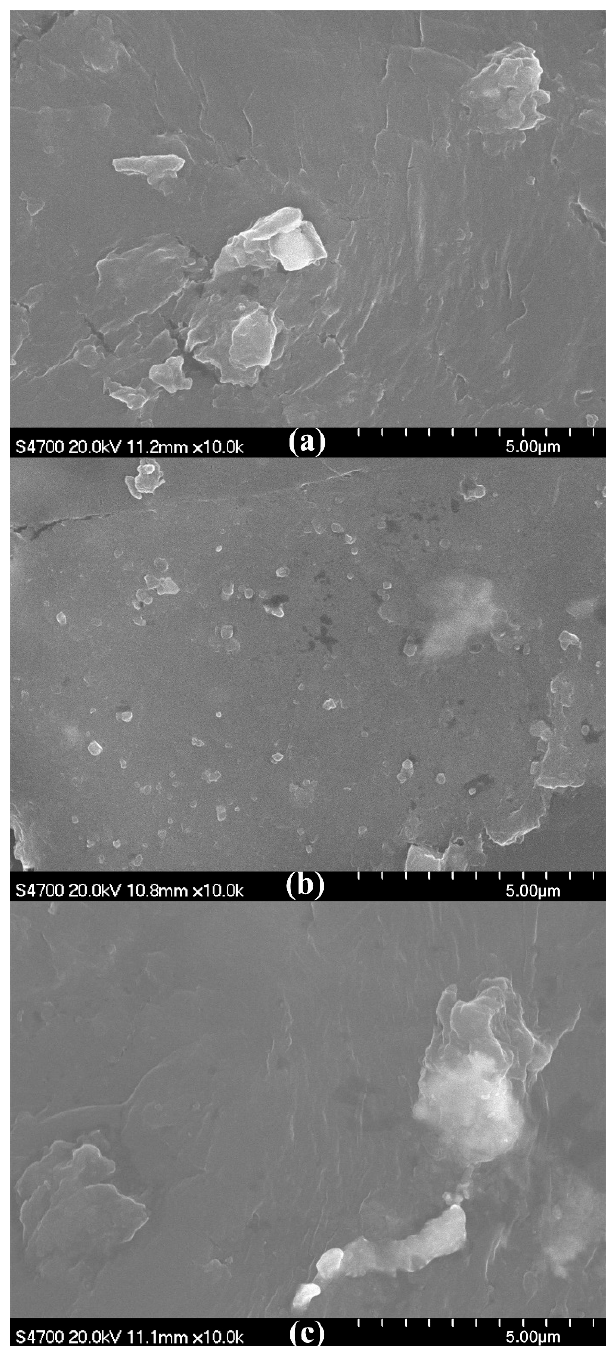
Figure 9. SEM micrographs of fracture surfaces of OMMT-modified UHMWPE. ( a ) w KH560 / w OMMT = 0.5%, ( b ) w KH560 / w OMMT = 1%, ( c ) w KH560 / w OMMT = 1.5%.